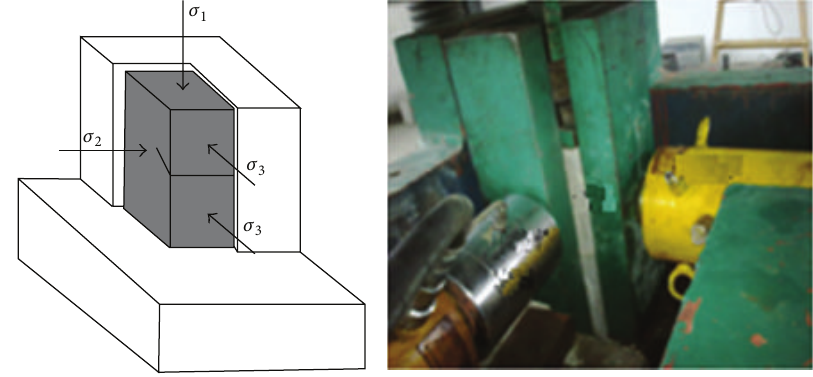
Figure 2: Diagram of load of testing model.